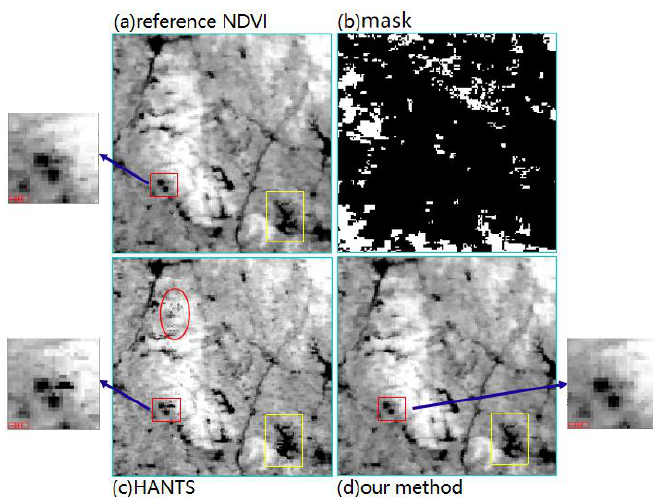
Figure 6. The second group of reconstructed